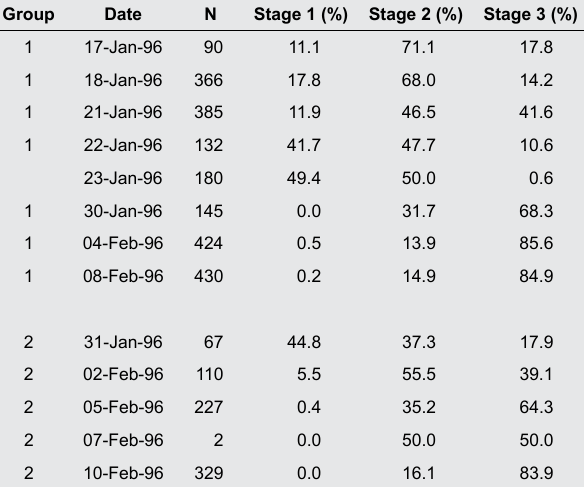
Table 3 . Proportion of pups in various age-dependent developmental stages during the 1996 southern Gulf surveys. Group 1 applies to strip-transect surveys flown 24, 26, and 27 January 1996. Group 2 applies to the strip- transect survey of 2 February 1996.